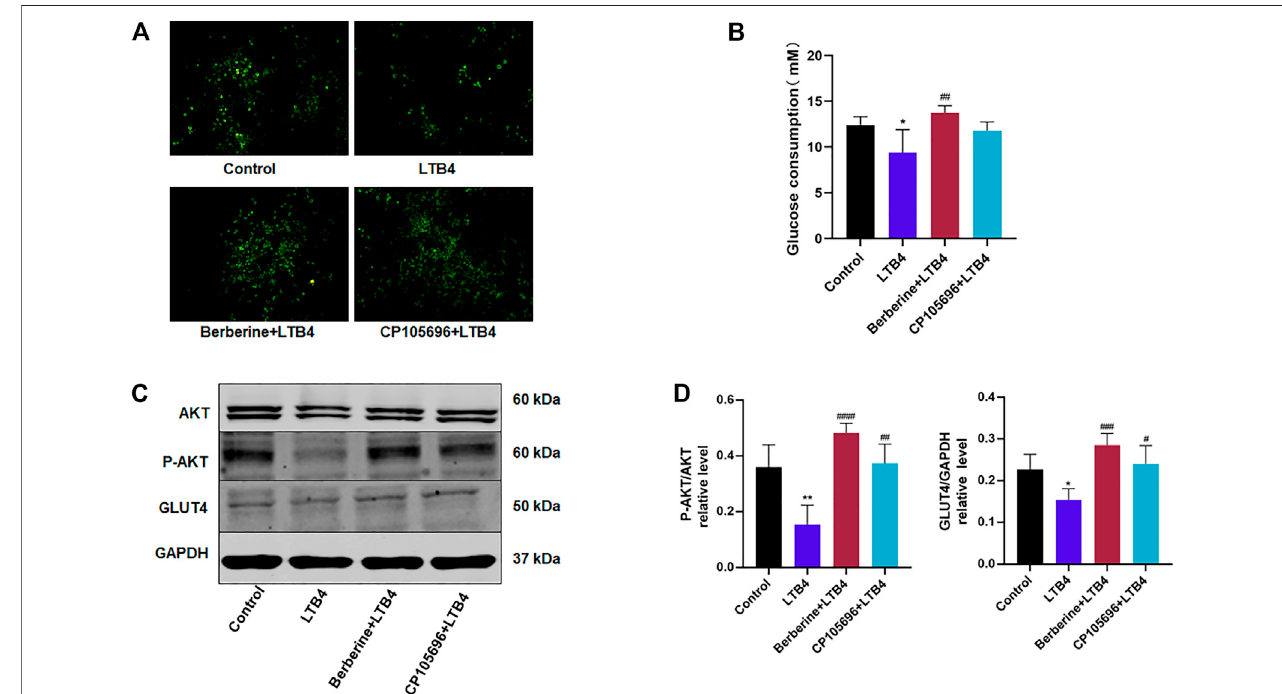
FIGURE1| BBR improved insulinresistance ofHepG2 cellsinducedbyLTB4. (A) Glucose uptakeof2-NBDG assaysfrom HepG2 cellsdetectedby fl uorescence microscopy. Scale bar, 200 μ m ( n (cid:2) 3). (B) Glucose consumption was determined using the glucose oxidase method. The amount of glucose consumption was calculated by subtracting the glucose concentrations of the blank wells from the remaining glucose in the cell-plated wells ( n (cid:2) 5). (C) Western blots showed the protein levels of the insulin signaling pathway (P-AKT, GLUT4). (D) Densitometric analysis of p -AKT and GLUT4 in total protein was calculated ( n (cid:2) 4). Error bars represent mean ± SD. BBR, Berberine, 10 μ M; CP105696, 10 μ M; LTB4, Leukotriene B4, 100 nM * p < 0.05 vs. Control; # p < 0.05 vs. LTB4. ** p < 0.01; ## p < 0.01; ### p < 0.001; #### p <